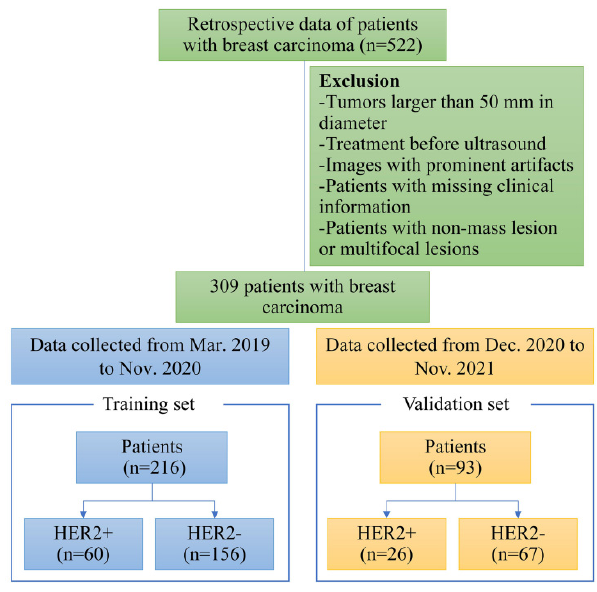
Figure 1. The patient enrollment process for this study.